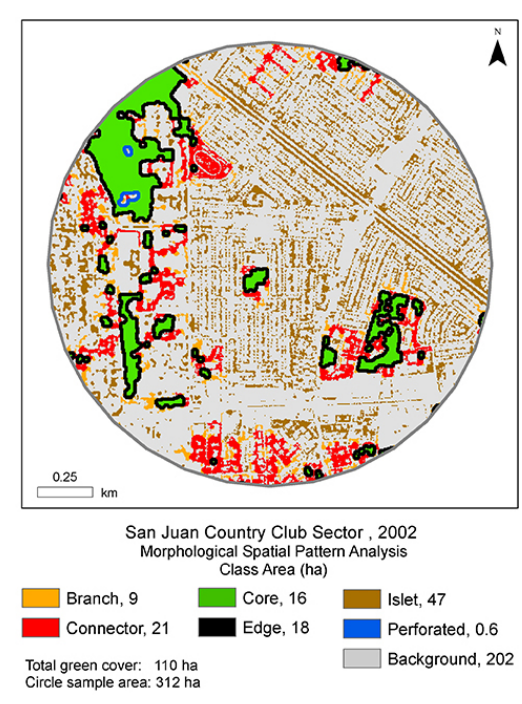
Fig. 4. Geographic distribution of green area spatial patterns in the Country Club sector of San Juan, Puerto Rico. The conspicuous abundance of islets mostly corresponds to the yards of individual households. Green areas along streets are also